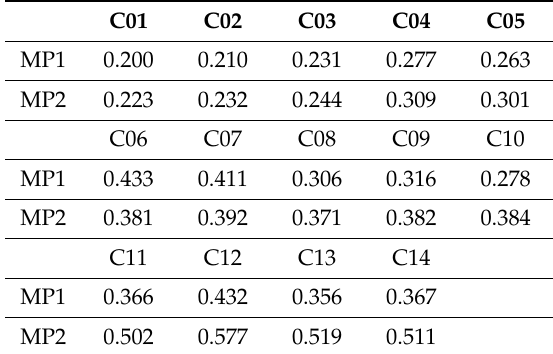
Table 2. The standard deviations of multipath combinations for BDS satellites (unit: